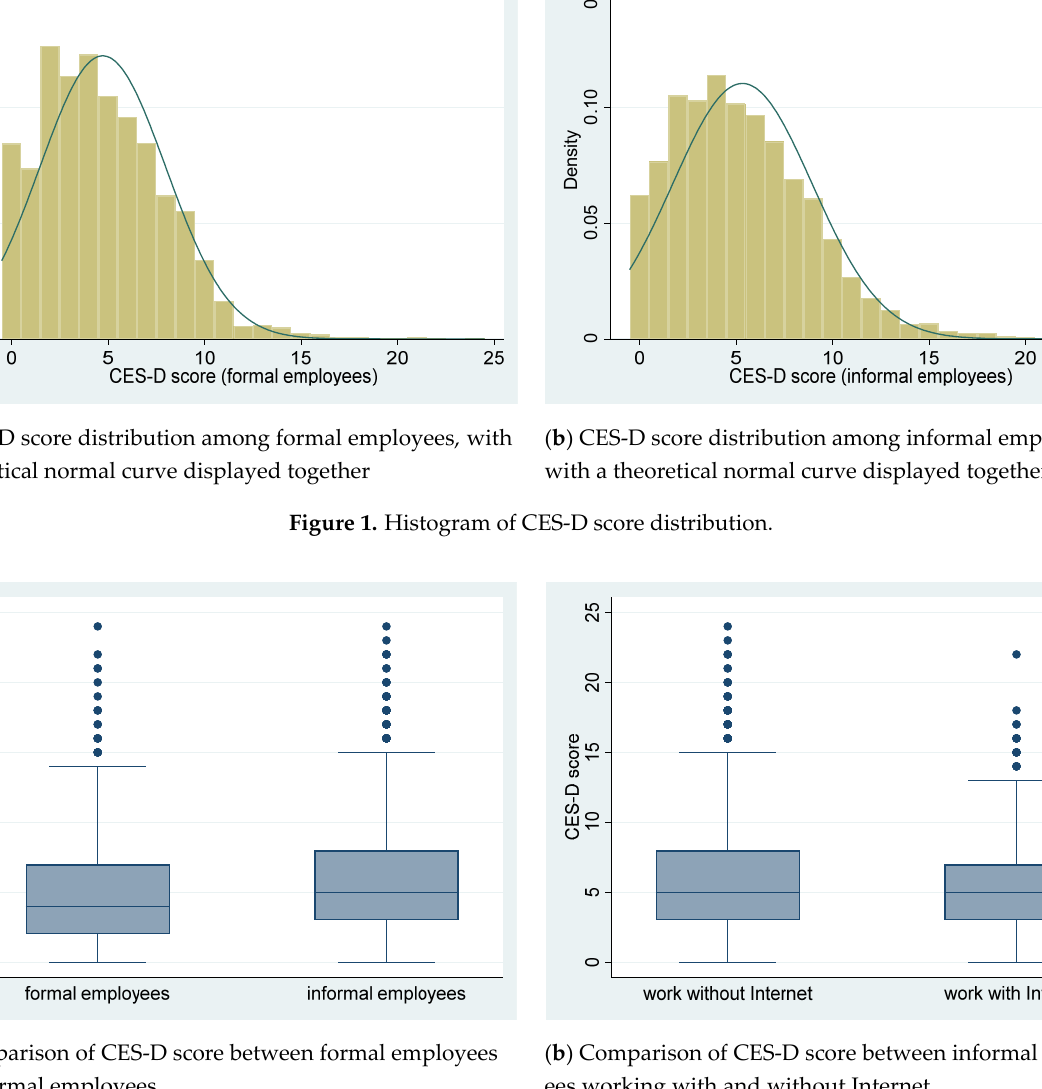
Figure 2. Boxplot of CES-D score comparison.